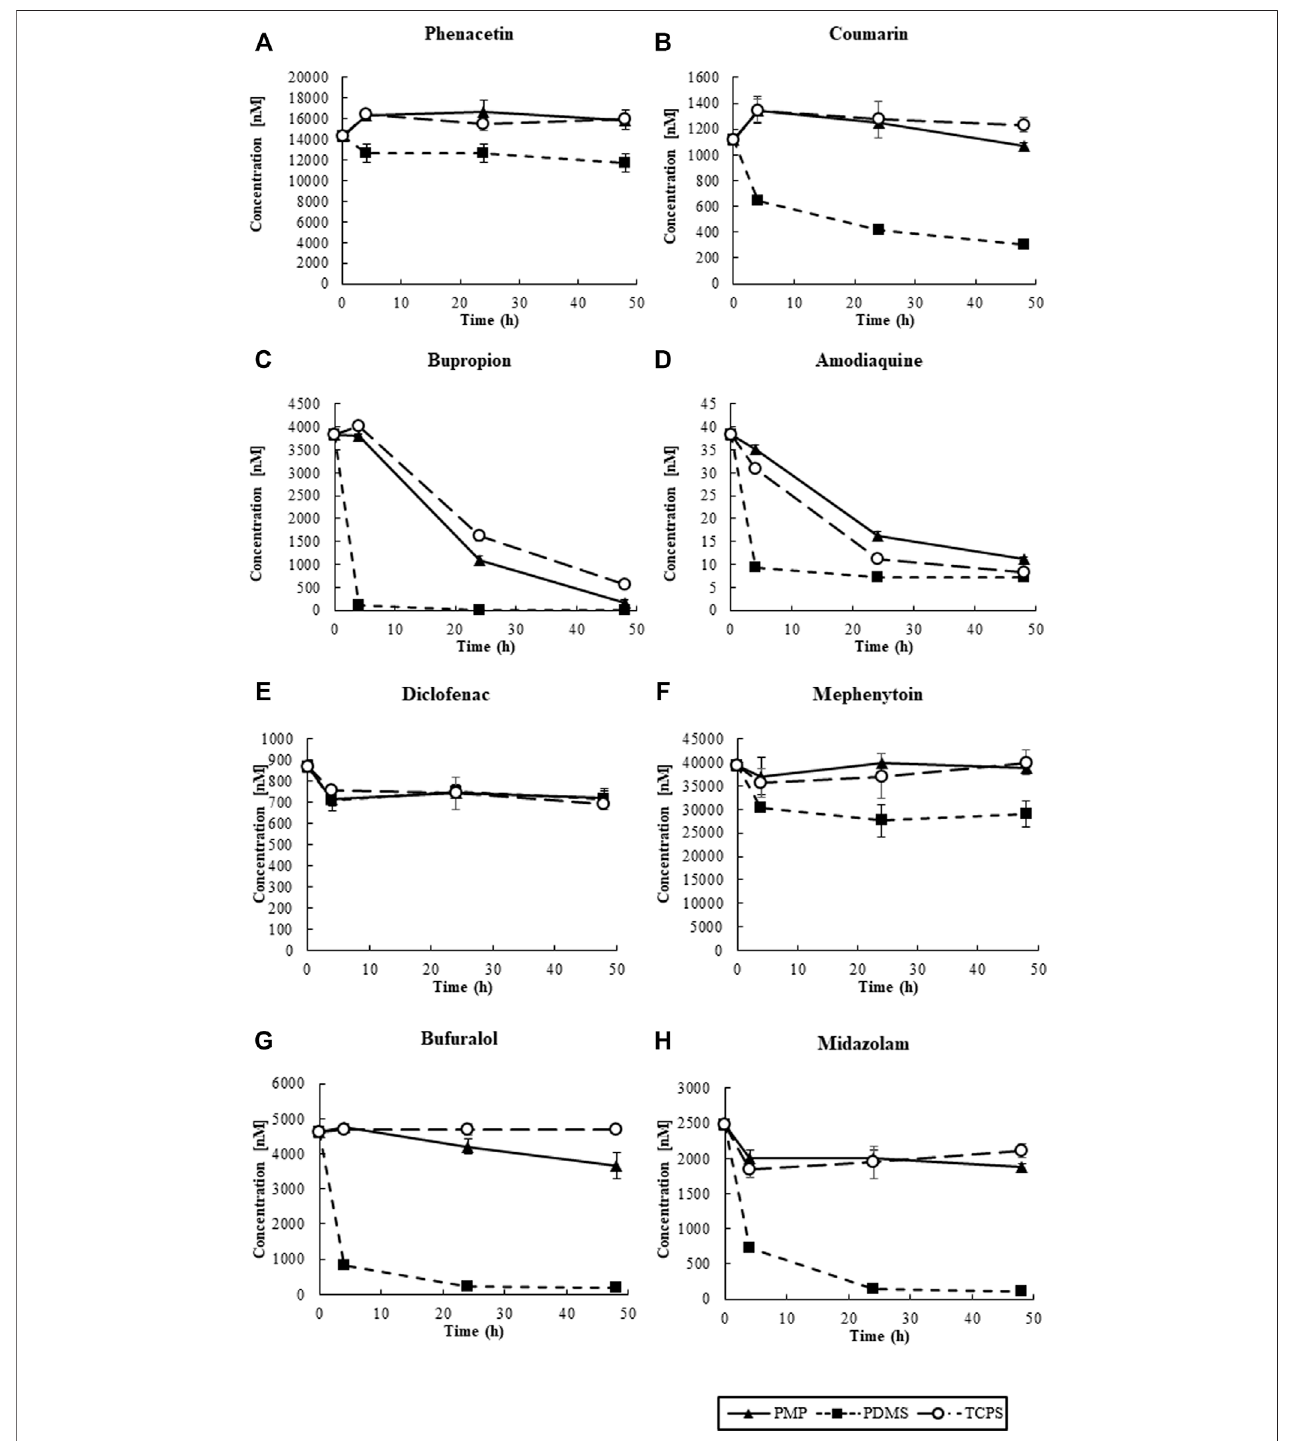
FIGURE 6 | The transition of the concentrations of CYP substrates in solution: (A) CYP1A2, (B) CYP2A6, (C) CYP2B6, (D) CYP2C8, (E) CYP2C9, (F) CYP2C19, (G) CYP2D6, and (H) CYP3A2 (N = 4).